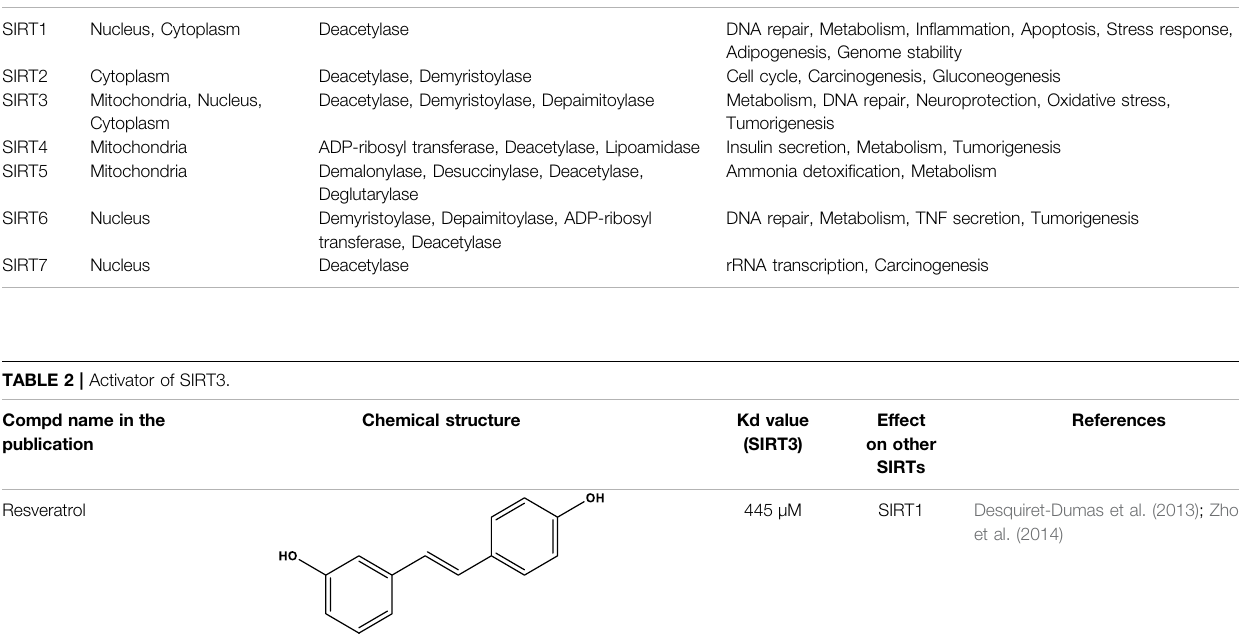
TABLE 1 | The characteristic of mammalian SIRTs. Species